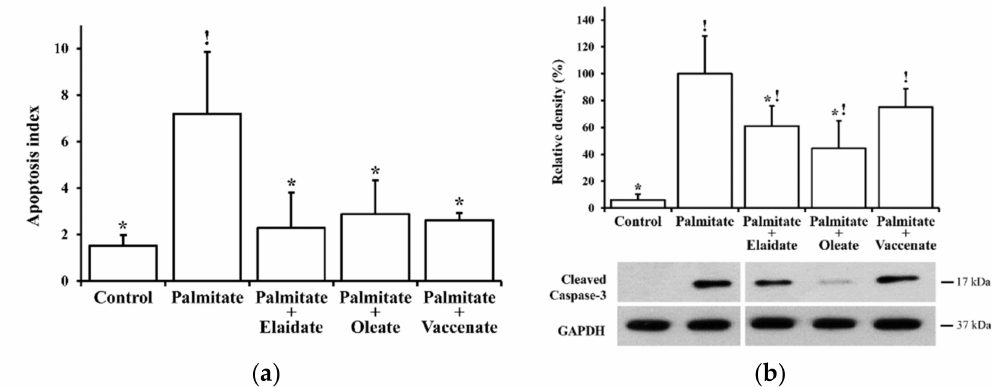
Figure 2. Lipoapoptosis. Cells were treated with BSA (control cells) or BSA-conjugated palmitate alone, or with palmitate in combination with one of the unsaturated fatty acids, elaidate, oleate or vaccenate at 500 µ M individual concentrations for 8 h at 70%–80% confluence. ( a ) Apoptotic cells / bodies were detected and counted by annexin and propidium iodide staining and fluorescence microscopy. Apoptosis index was calculated as the relative number of apoptotic cells and expressed as percentage of the total cell number. ( b ) Cleaved caspase-3 was detected by Western blot in cell lysates. The image shows typical results of three independent experiments with two parallels. The results were quantified by densitometry, normalized to glyceraldehyde 3-phosphate dehydrogenase (GAPDH) as a constitutive reference protein and are shown as relative band densities in the percentage of palmitate values. Data in all diagrams are shown as mean values ± S.D; n = 6; statistically significant di ff erences: ! p < 0.05, vs. BSA-treated control; * p < 0.05, vs. palmitate-treated